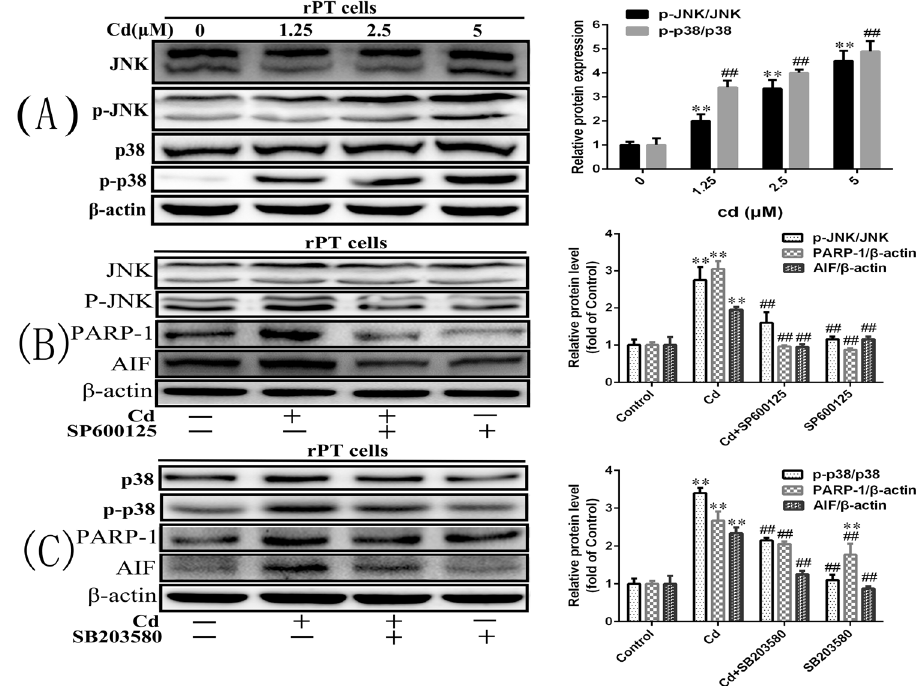
Figure 10. A ctivation of JNK1/2 and p38 protein by Cd-induced parthanatos in primary rPT cells. ( A ) Cd activates the JNK1/2 MAPK and p38 MAPK pathway in primary rPT cells. ( B and C ) Inhibition of p-JNK or p-p38 protein activity can reduce the expression of PARP-1 and AIF. The quantitative analysis was performed on the western blotting results of three independent experiments (mean ± SD, n = 3). Respectively, ** P < 0.01 vs. the control group by one-way ANOVA. ## P < 0.01 vs. the Cd group by one-way